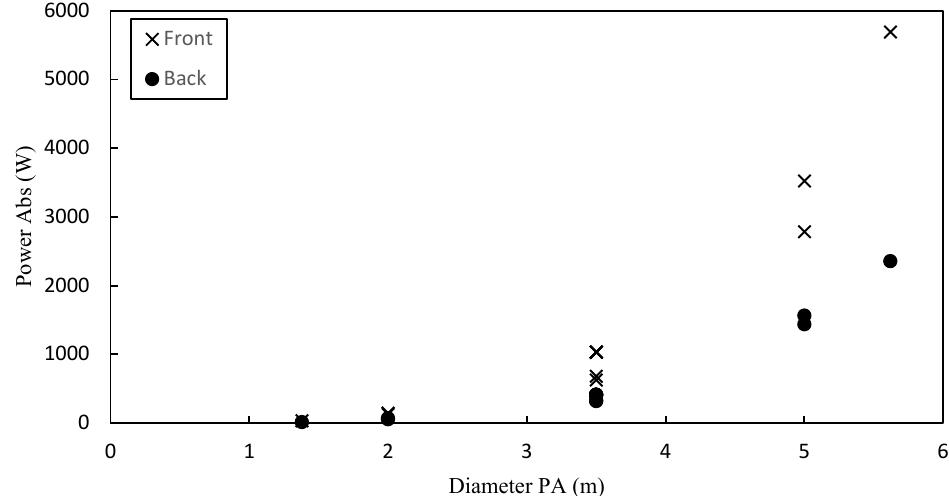
Figure 12. Maximum Power Absorption Versus Diameter PA for Front and Back PA Positions.